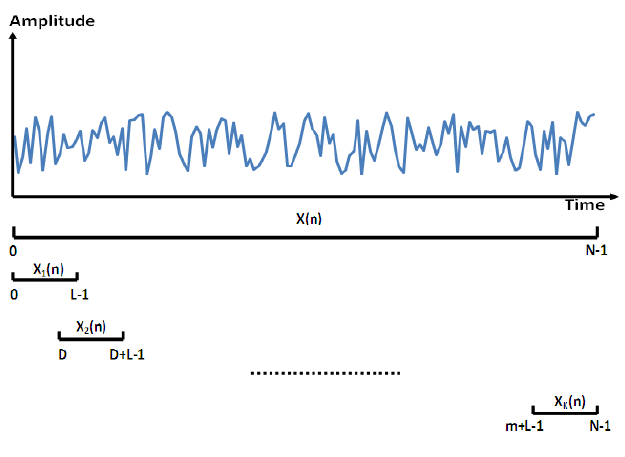
Figure 2. Illustration of the record segmentation.